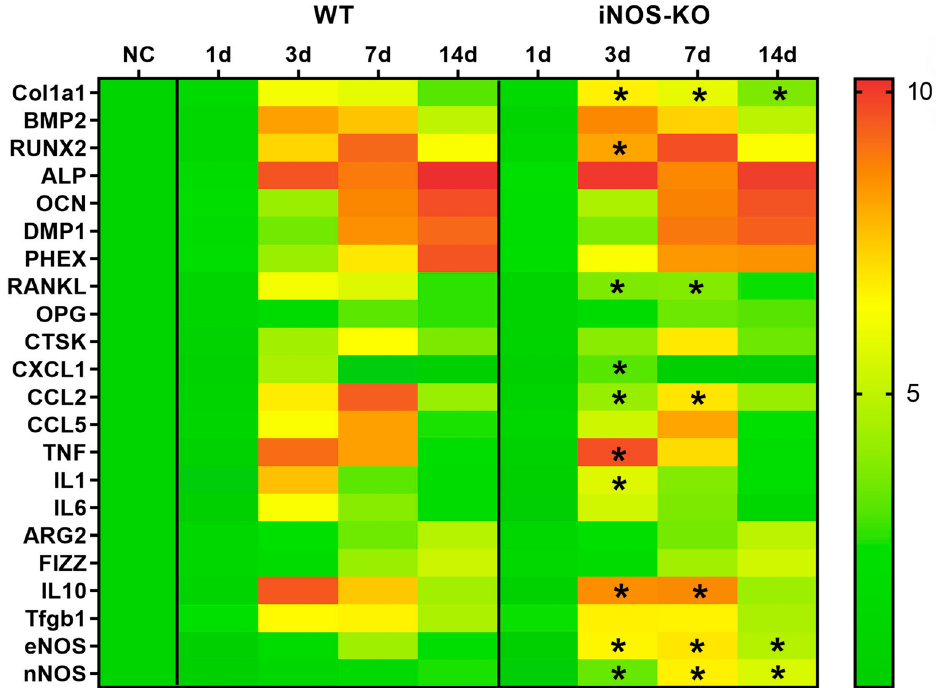
Figure 5- Molecular analysis of the alveolar bone healing analysis of the kinetics of the bone healing process in C57Bl/6 WT and iNOS- KO mice. Samples from C57BL/6 wild-type (WT) and iNOS-KO mice were subjected to Real-Time PCR array analysis at zero, seven, 14, and 21 days post tooth extraction to evaluate the kinetics of gene expression of the bone healing process. Molecular analysis (Real-Time PCR array) using a heat map to quantify the expression of the ECM and bone formation markers, osteoclast markers, inflammatory cytokines, M1 and M2 markers, and iNOS isoforms eNOS and nNOS were evaluated. Results are expressed as fold change relative to a normalizing control (C, i.e., normal alveolar bone) sample and normalized by three constitutive genes (GAPDH, ACTB, Hprt1); * represents the differences (p<0.05) between iNOS and WT group at each time